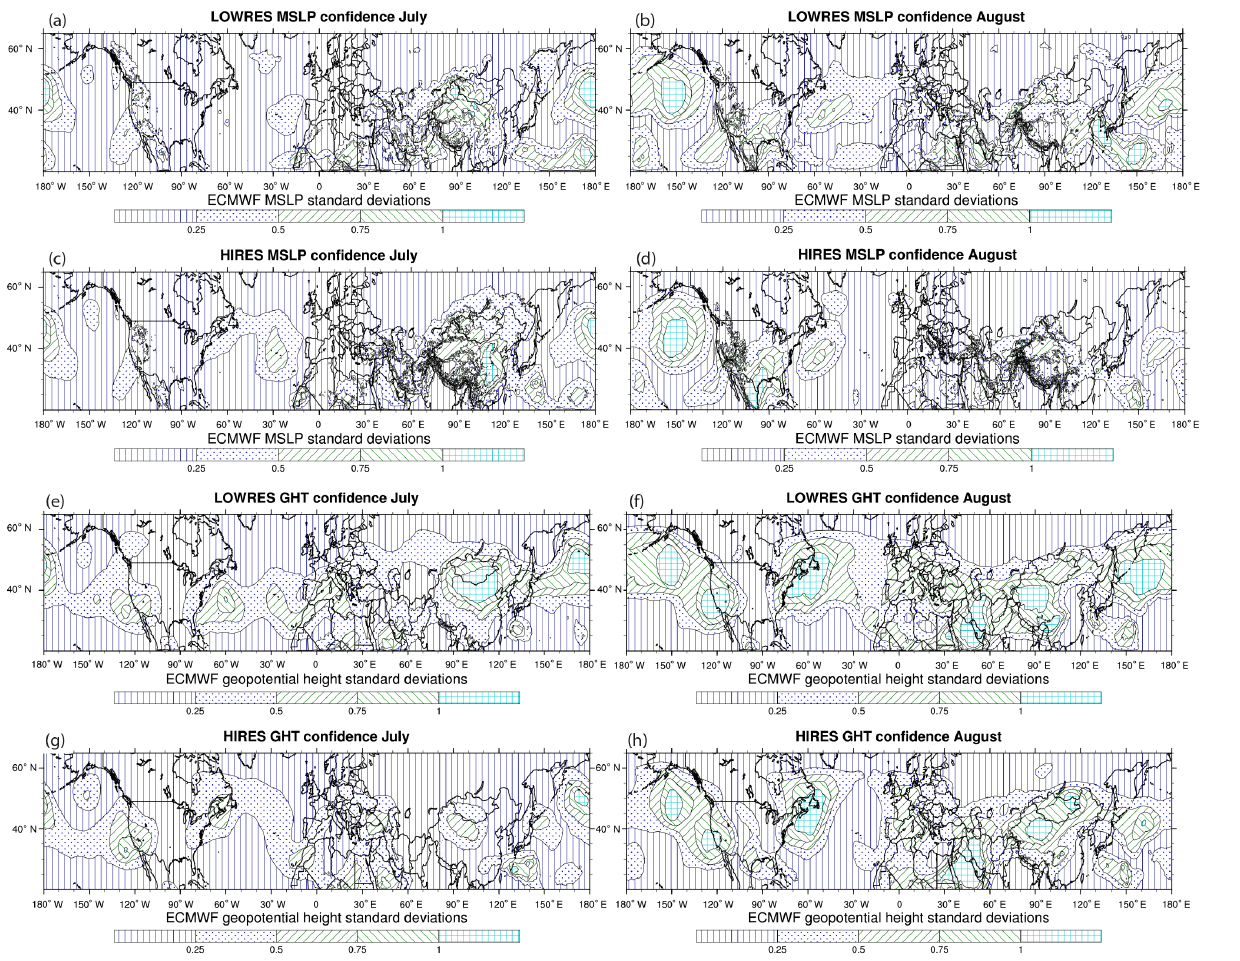
Figure 6. Model biases expressed in absolute terms of 2 ECMWF standard deviations for the LOWRES simulation (a, b, e, f) and the HIRES simulation (c, d, g, h) for the 12:00UTC time steps. Left column: July 2013. Right column: August 2013. First two rows: mean sea level pressure. Bottom two rows: 500hPa geopotential